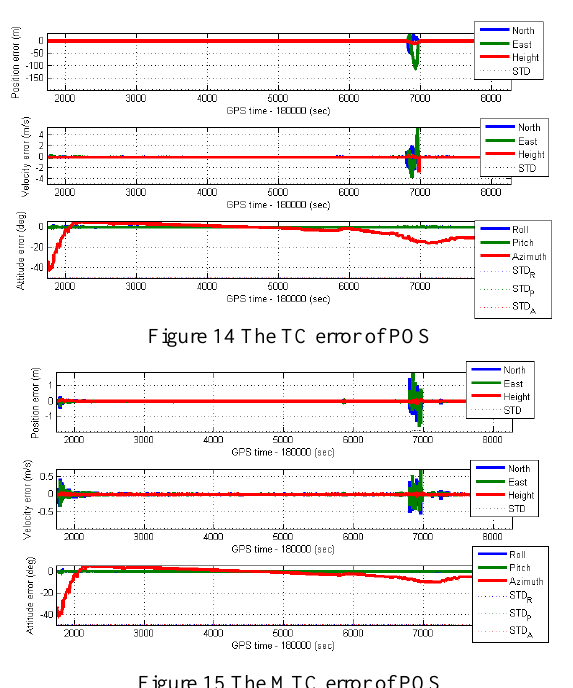
Figure 15 The MTC error of